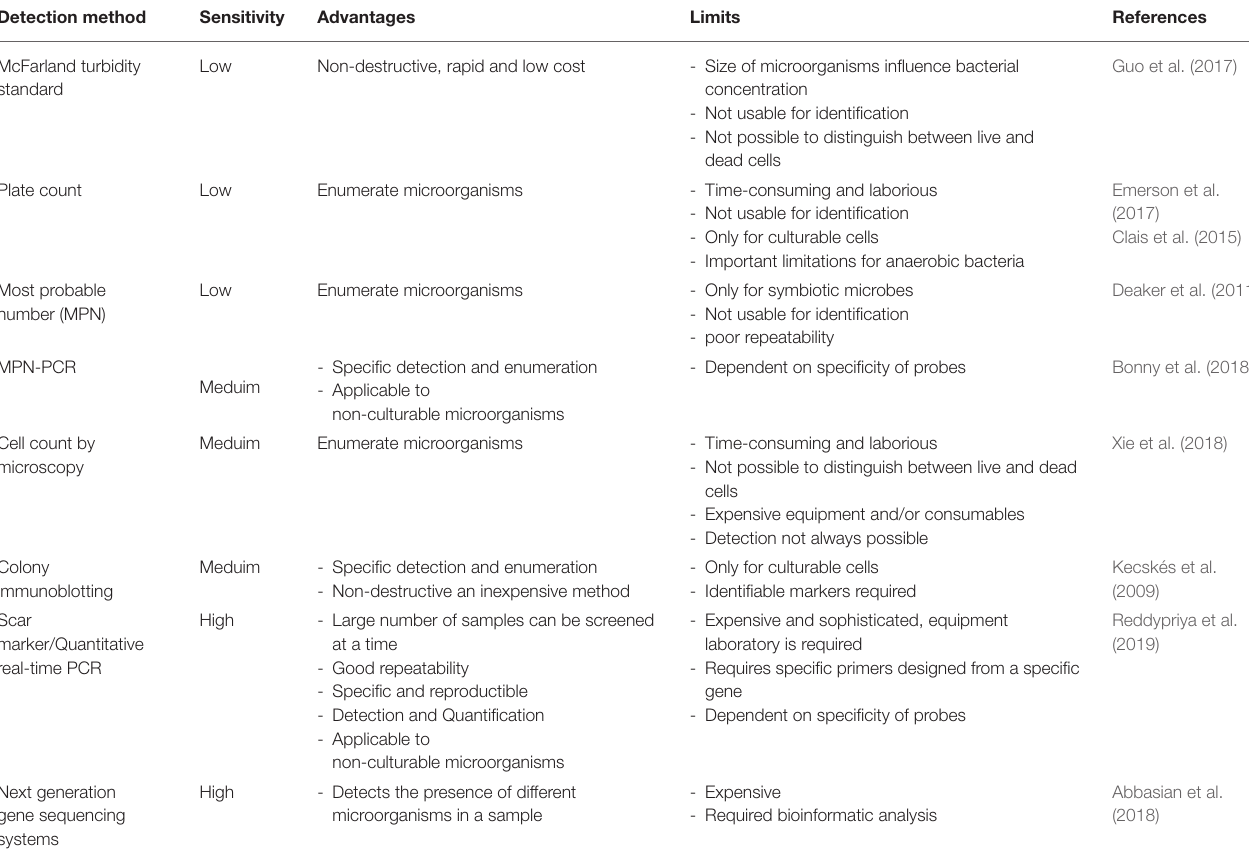
TABLE 2 | Reliability comparison of some methods for detection and